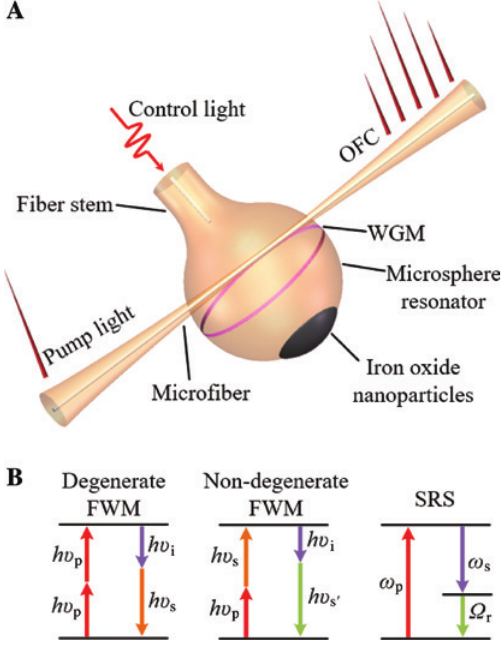
Figure 1: Schematic diagram of the proposed device. (A) Illustration of tunable optical frequency comb generated in the functionalized silica microsphere resonator. The pink ring represents the light propagation path and the black area denotes the ironoxide-nanoparticle-coated area. (B) General principle for OFC generation and stimulated Raman scattering. h is the Planck constant and v are the frequencies of the pump, signal, and idler p,s,I lights, respectively. ω and Ω are the frequencies of the pump p,s r light, Stokes light and optical phonon,